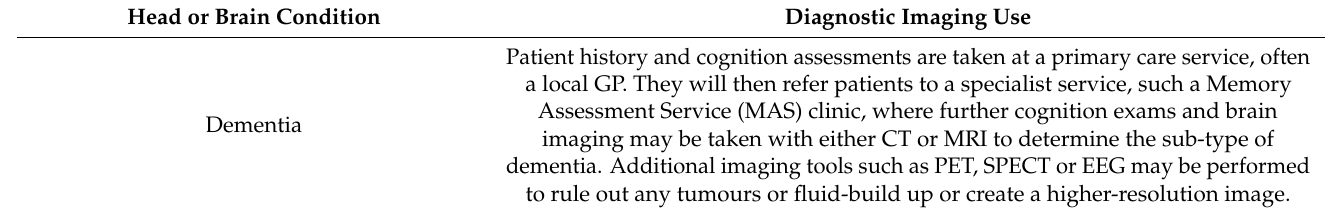
Table 1. Overview of the use of diagnostic neuroimaging techniques in dementia, minor head injury, stroke, cancer, epilepsy, CIDP and Parkinson’s disease. This table describes the type of neuroimaging technology recommended for use in the U.K. for the diagnosis of dementia, MHI, stroke, cancer, epilepsy, CIDP and Parkinson’s disease. Recommendations are based on NHS and NICE guidelines. Information was sourced from various resources [14–21]. Refer to the list of abbreviations. Head or Brain